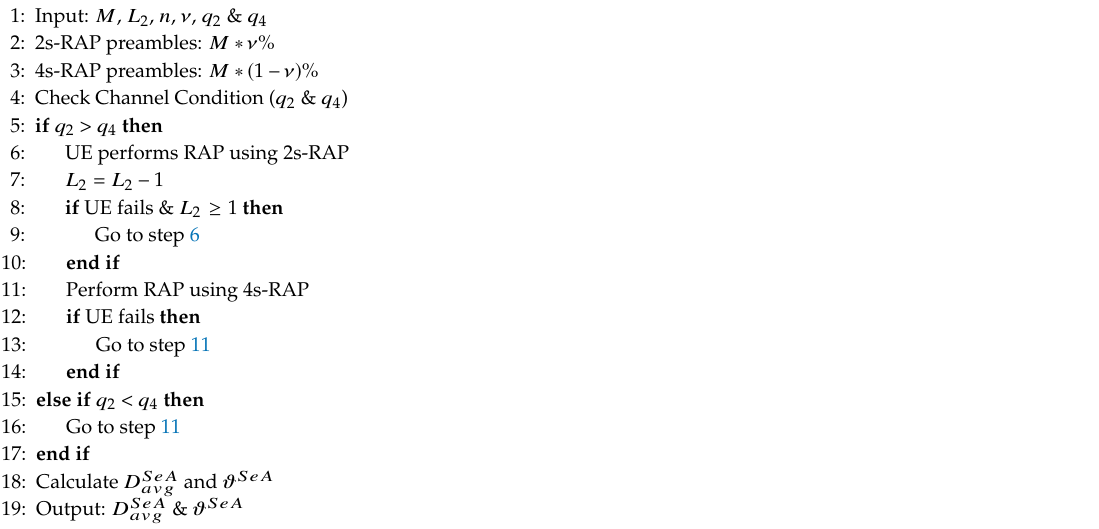
Algorithm 2 2s-RAP and 4s-RAP using sequential algorithm